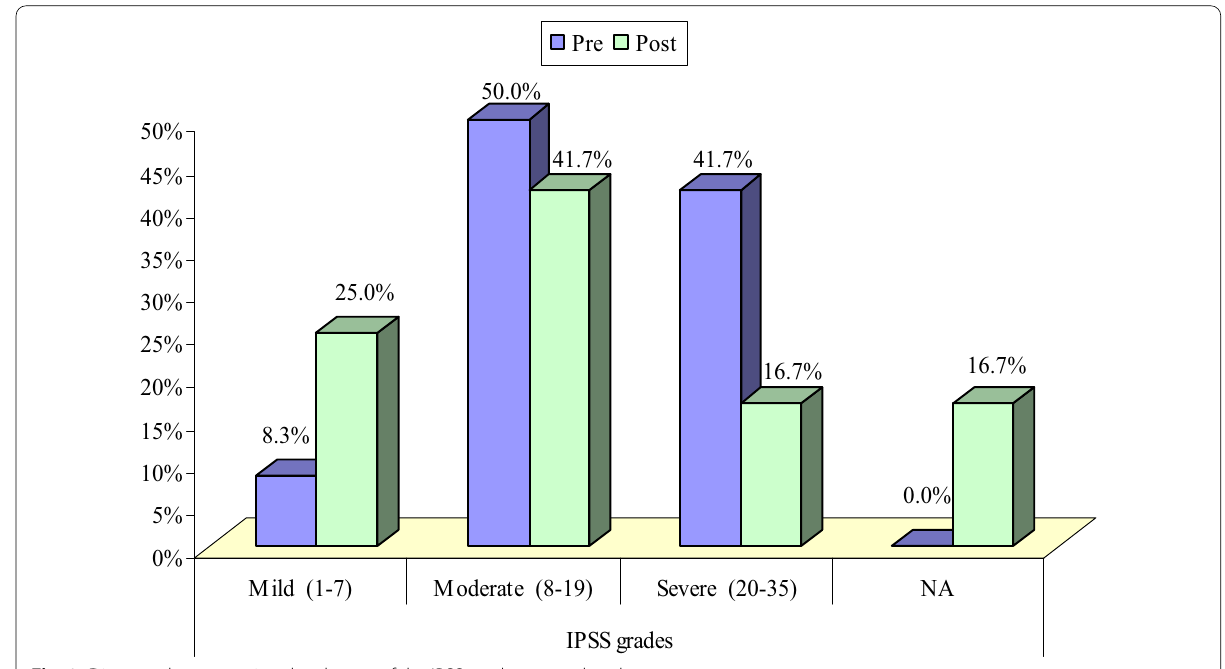
Fig. 9 Diagram demonstrating the change of the IPSS grades post sclerotherapy